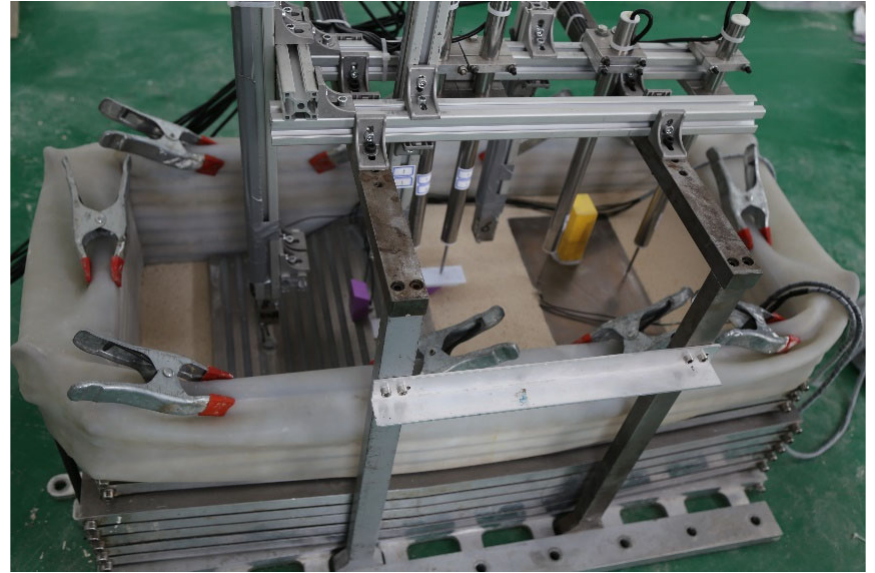
Figure 5. A real view of the completed physical